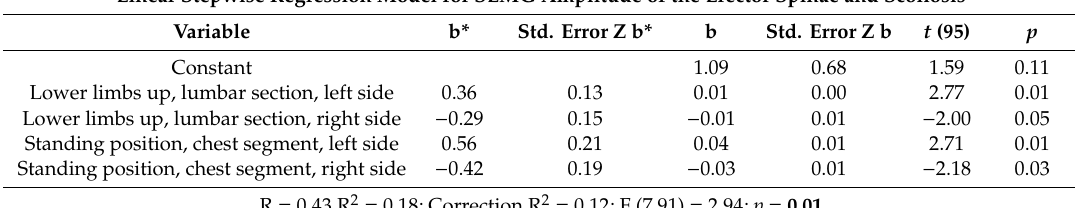
Table 5. Linear stepwise regression model for SEMG amplitude of the erector spinae in children with scoliosis 1